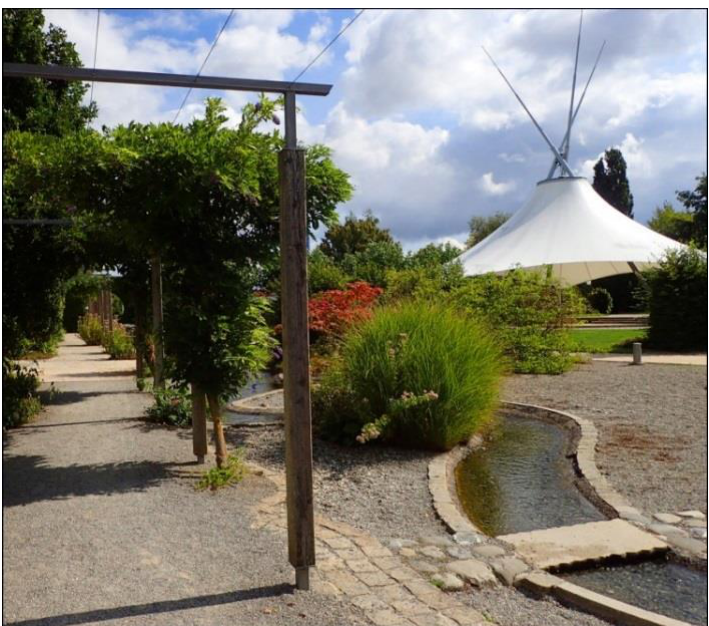
Figure 6. The interior of the spa park in Bad Saulgau. The main element of the layout's composition is a canal fuelled by thermal water procured for the health